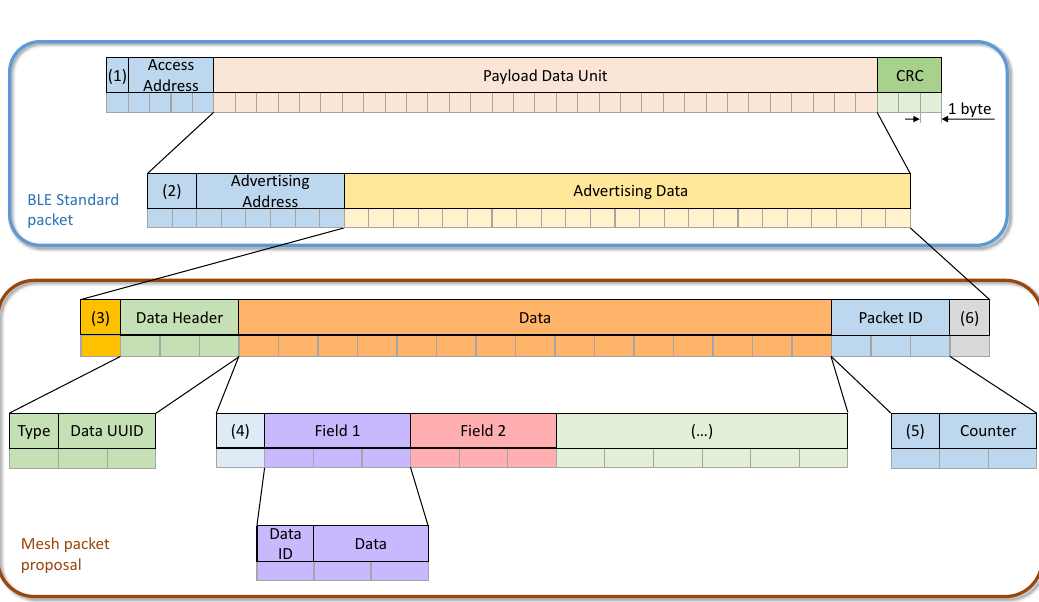
Figure 13. Our proposed mesh packet format. (1) Preamble; (2) BLE Header; (3) Advertising Data Length; (4) Destination Device ID; (5) Source Device ID; (6)